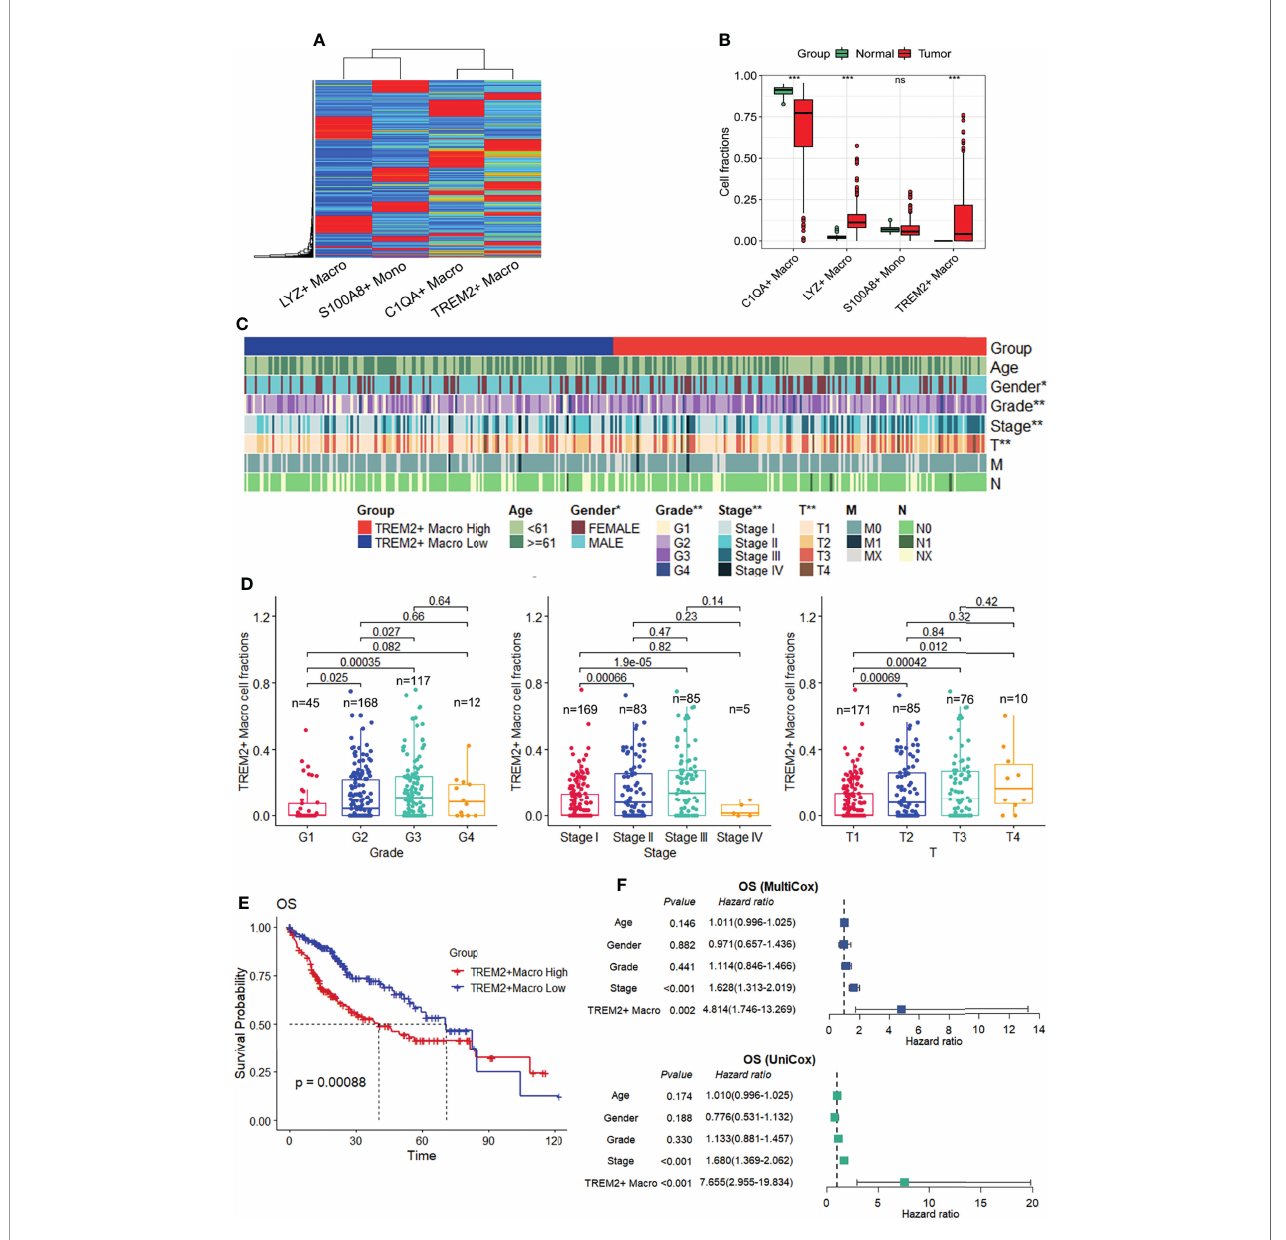
FIGURE 7 | Prognostic role of the TREM2 + macrophage subtype in the TCGA-LIHC cohort. (A) The signature matrix created by CIBERSORTx. (B) Box plot showing the relative frequency of macrophage subtypes and monocyte in fi ltration calculated by CIBERSORTx with the default relative mode, which normalizes all cell fractions of the cell types in the signature matrix to 100%. Signi fi cance was determined by unpaired Wilcoxon test. (C) Strip chart showing the distribution of common clinical features, including tumor grade, AJCC pathologic stage, AJCC pathologic T, AJCC pathologic N, and AJCC pathologic M, in patients with a high or low fraction of TREM2 + macrophages. * P < 0.05, ** P < 0.01. (D) Frequency of TREM2 + macrophages in patients with different tumor grades, pathologic stages, and T stages. P values were determined by chi-square tests. (E) Kaplan-Meier survival curves showing the overall survival (OS) of patients in the TCGA-LIHC cohort according to the frequency of TREM2 + macrophages. P -values were calculated using log-rank tests. (F) Univariate (top) and multivariate (bottom) Cox hazard ratio analyses of